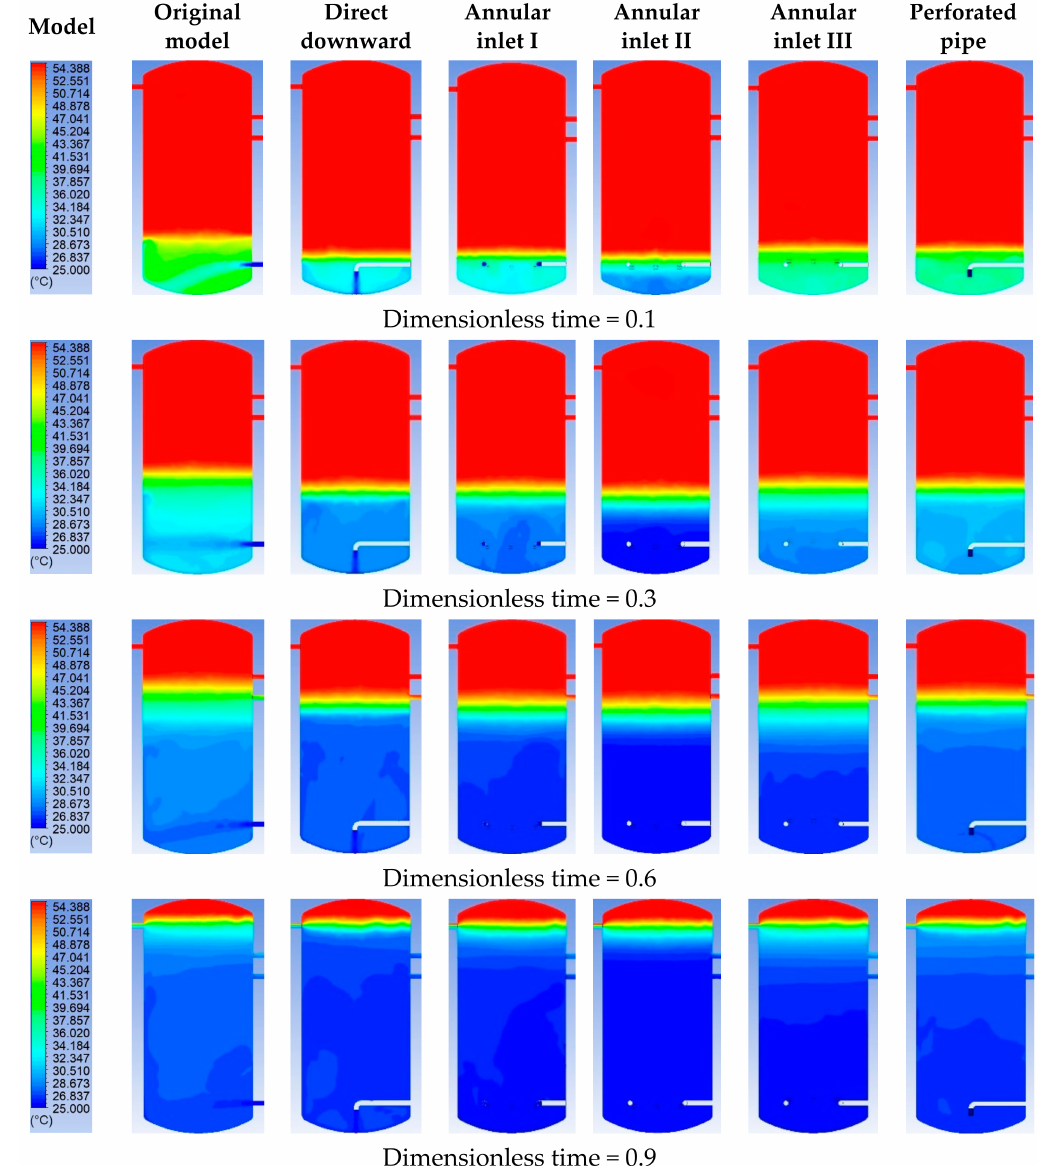
Figure 10. The temperature contours of the modified inlet pipe models.